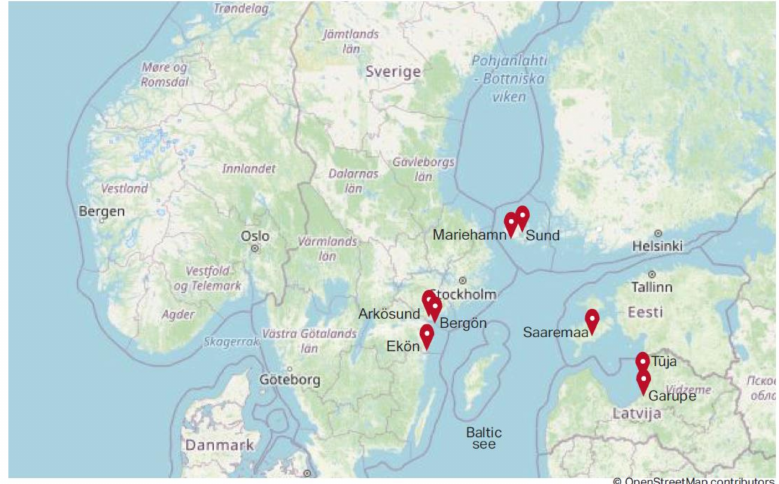
Figure 1. Pilot areas of the present study on the Baltic Sea region